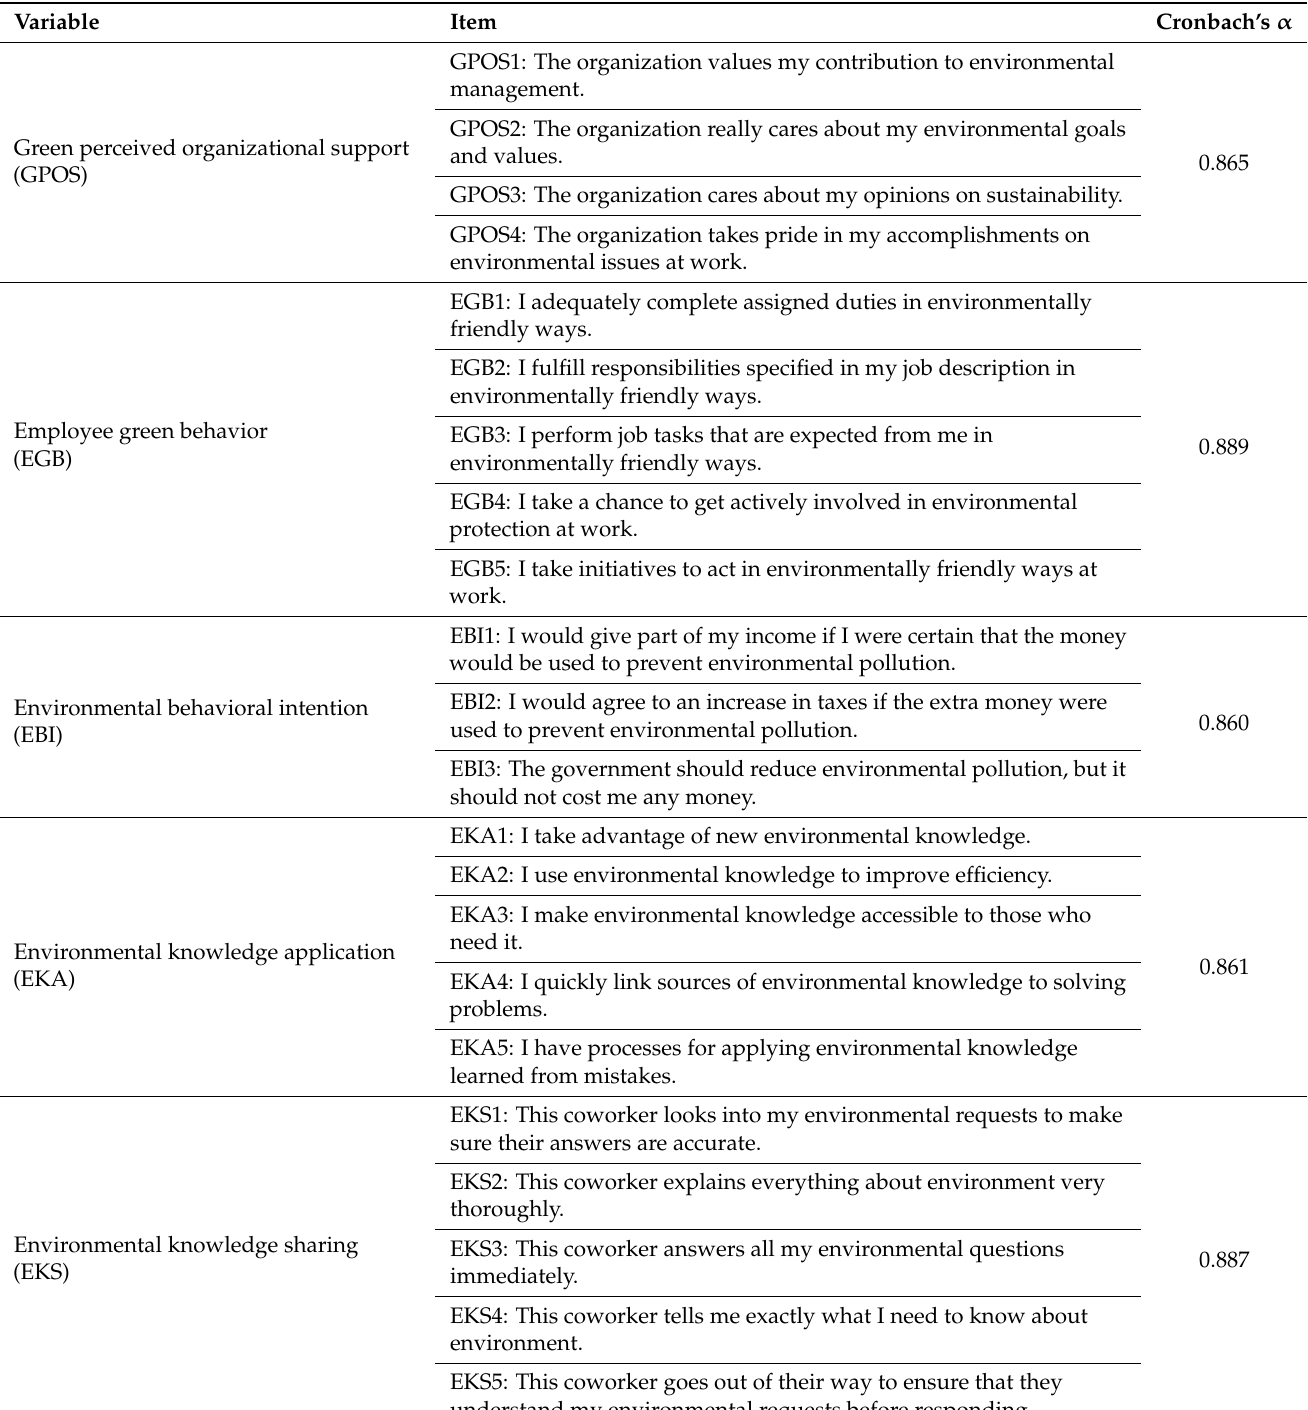
Table 2. Items for